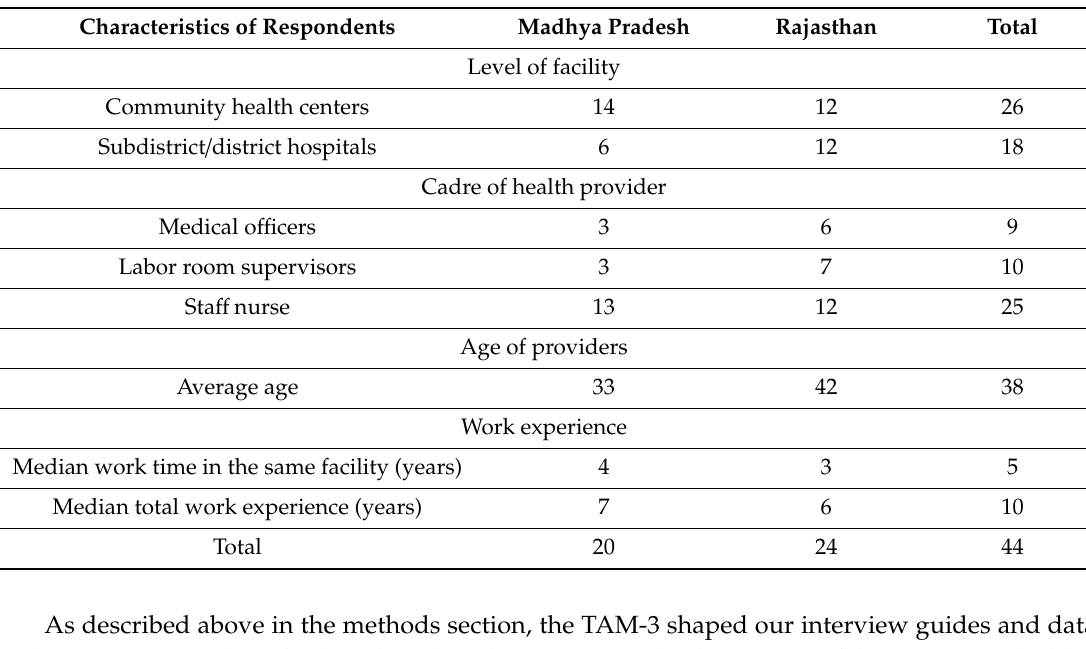
Table 2. Characteristics of respondents.